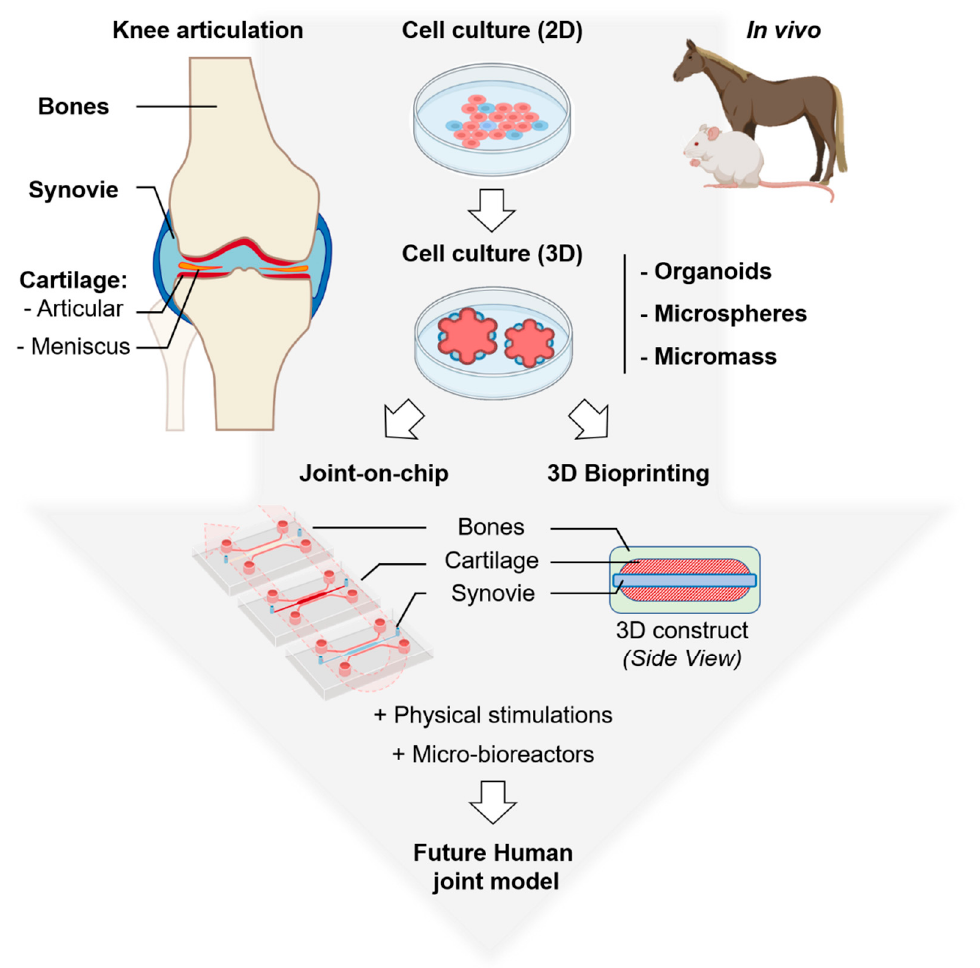
Figure 1. Overview of the biological models commonly used: ( top ) animals, 2D and 3D cell cultures and ( bottom ) emerging: joint-on-a-chip and 3D bioprinting to study human articulation and its related diseases. Organoids are complex clusters of organ-specific cells, microspheres refer to shape-specific, macroporous scaffolds seeded with cells and micromass corresponds to high-density 3D cell cultures with multilayered organization. Top left, a schematic representation of the whole knee articulation, bones are in light brown, synovial cavity in light blue, articular cartilage in red and meniscus in orange, this color code was used for all the figures. Parts of the figure were created using biorender.com.